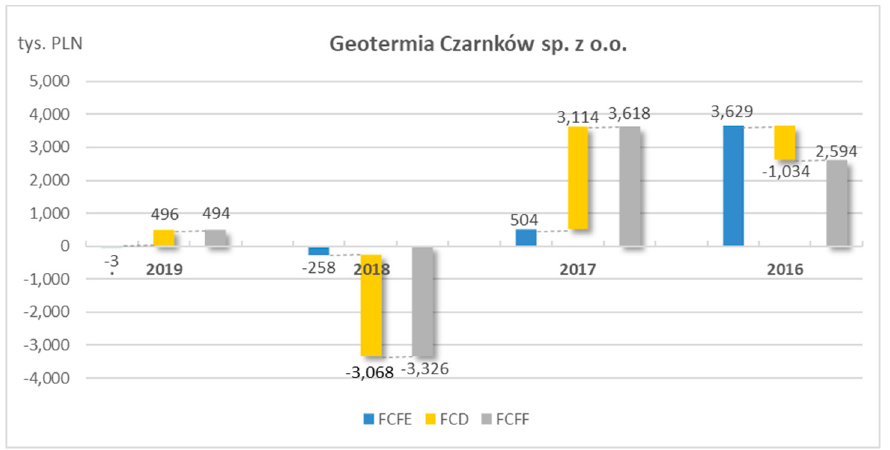
Figure 9. Formation of FCFE, FCD and FCFF in Geotermia Czarnków Sp. z o.o. Source: Own study on the basis of: [55].